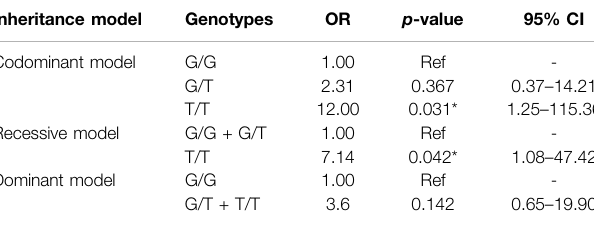
TABLE5| Univariatelogisticregressionbetween CYP2B6 c.516G > T(rs3745274) and nightmares in EFV-treated patients. Inheritance